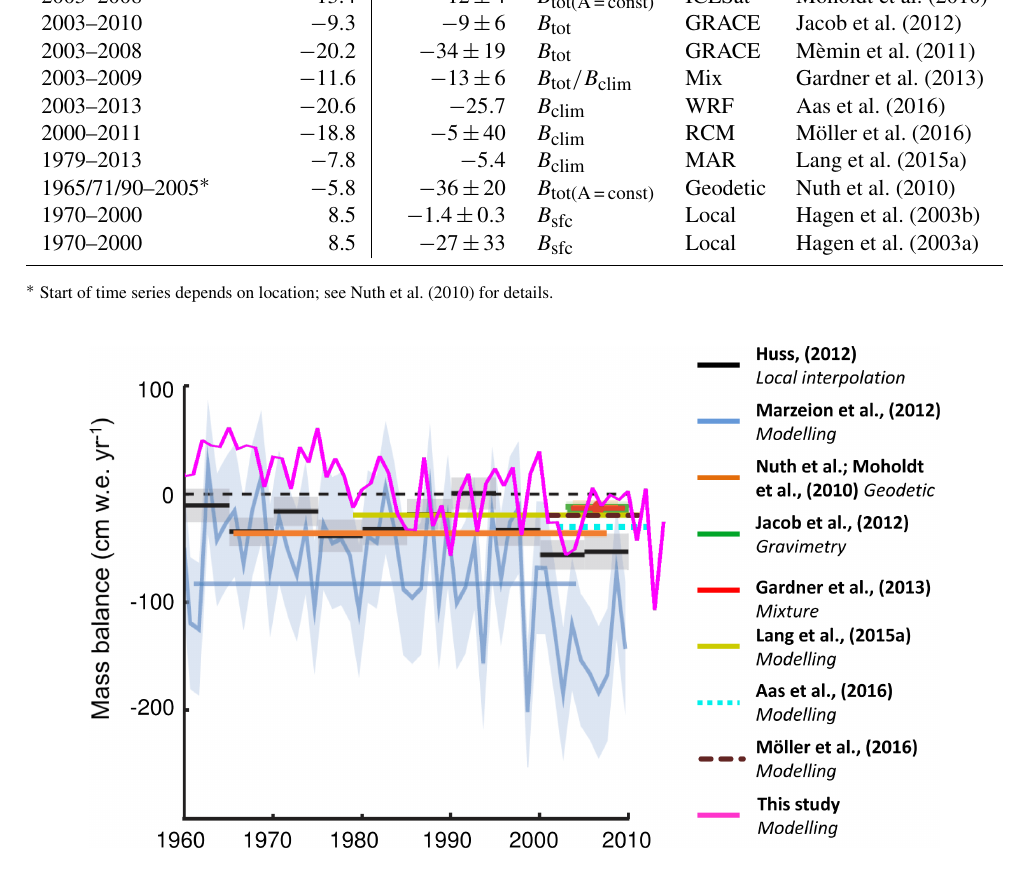
Figure 12. Svalbard mass balance estimates from different studies (bold font in legend) and methods (italic font). Shaded area of Huss (2012) and Marzeion et al. (2012) indicate the uncertainty. Figure modified from Vaughan et al. (Fig. 4.11.